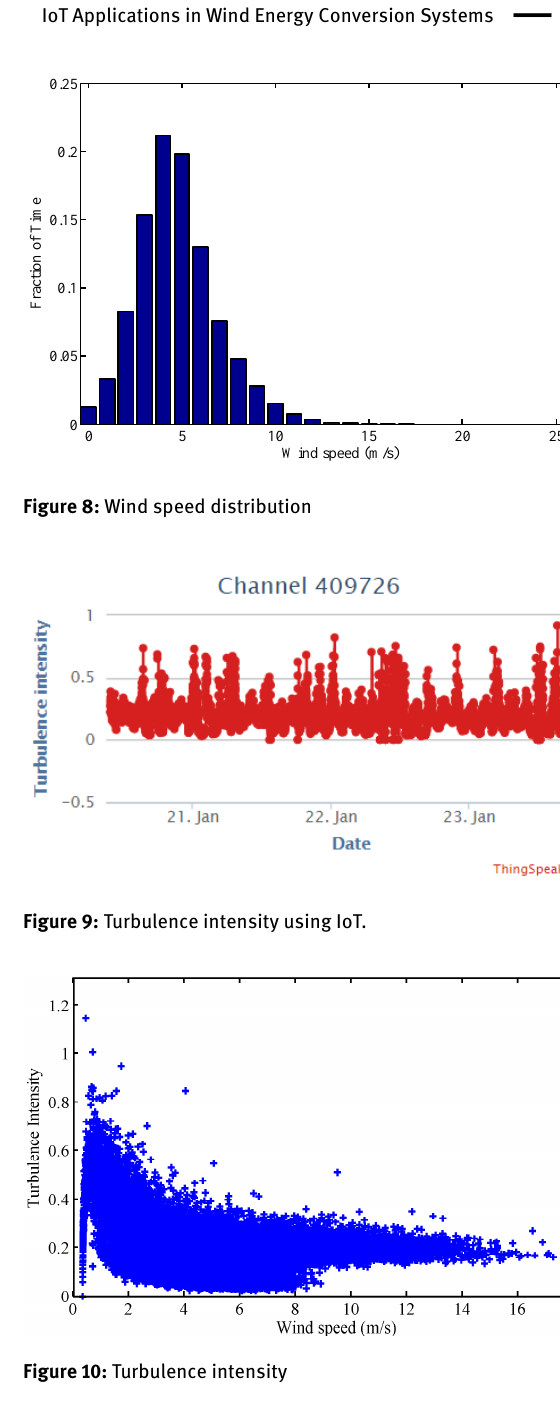
Figure 7: Wind rose